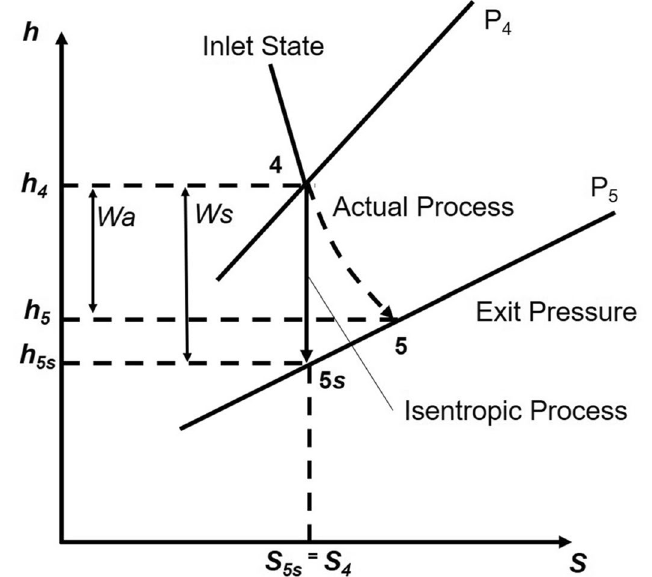
Fig. 4 Schematic diagram of a separator, demister, and flash tank. The separator ensures that only clean, dry steam enters the turbine; a demister is used to remove any leftover liquid droplets from steam, and a flash tank gathers a variety of condensate drain